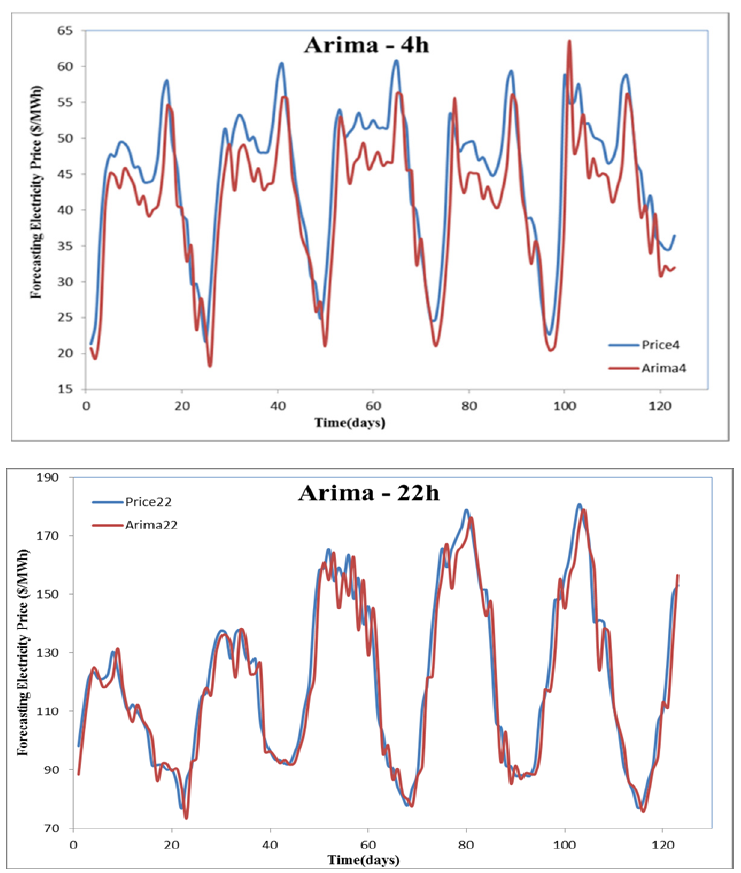
Figure 6. Performances of ARIMA models for 4 h & 22 h.